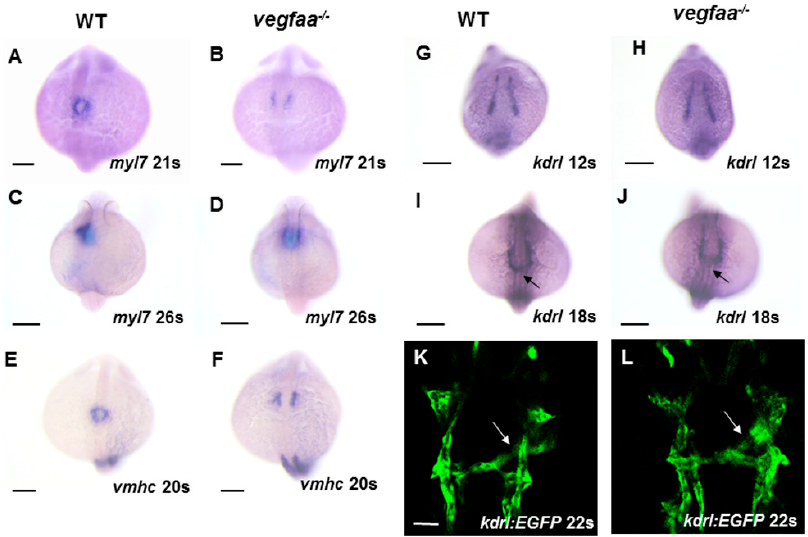
Figure 3. vegfaa mutants display defects in cardiomyocytes fusion. ( A – D ) In situ hybridization depicts myl7 expression at 21- and 26-somite stage in wild-type embryos ( A , C ) and vegfaa mutant embryos ( B , D ). At 21-somite stage, the wild-type cardiomyocytes formed a ring ( A ), whereas few cardiomyocytes are formed in the vegfaa mutants ( B ). At 26-somite stage, the wild-type primitive heart tube begins left looping ( C ) while vegfaa mutant embryos are still cardiac cone ( D ); ( E , F ) In situ hybridization depicts ventricular myosin heavy chain ( vmhc ) expression at 20-somite stage in wild-type embryos ( E ) and vegfaa mutant embryos ( F ); ( G – J ) Dorsal views depict unaffected endocardial expression pattern of kdrl in vegfaa mutants. Black arrows indicate midline migration of endocardial cells; Scale bar: 200 µ m ( A – J ); ( K , L ) Dorsal views depict endocardial expression of Tg ( kdrl:EGFP ) at the 22-somite stage. White arrows indicate leftward movement. Scale bar: 50 μ m.